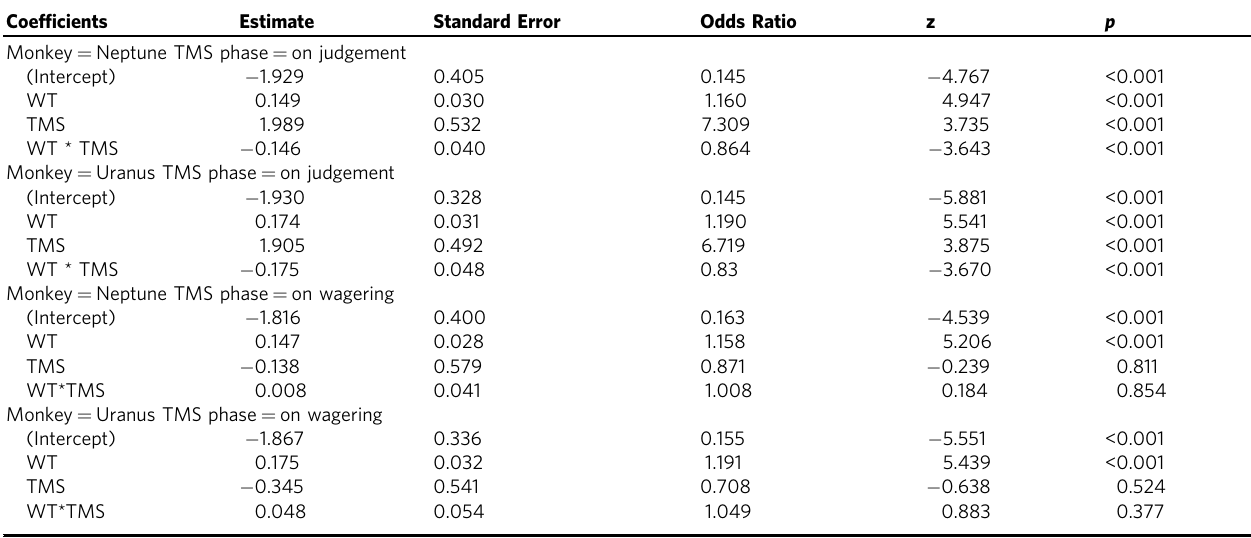
Table 2 Individual fi tting of data from the TMS experiment by logistic regression. Coef fi